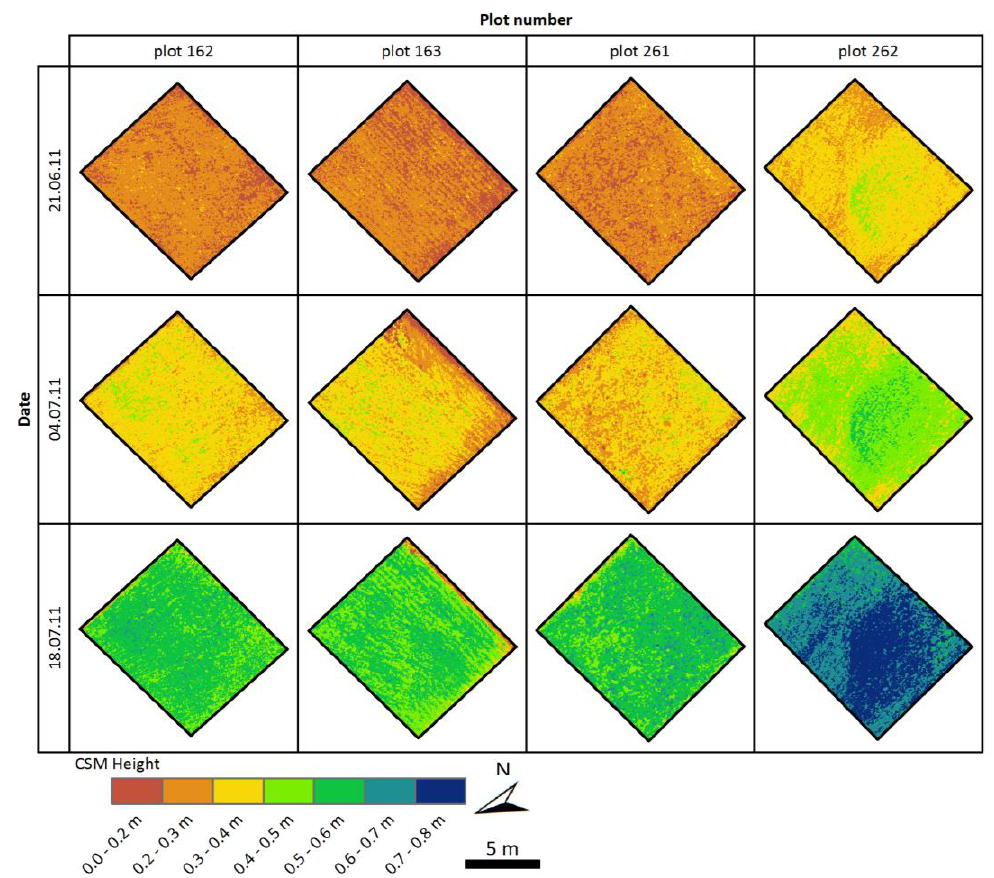
Figure 3. Maps of Crop Surface Models for four selected plots, showing the results for all three dates. The height is always calculated by subtracting the DSM of each date from the DTM.